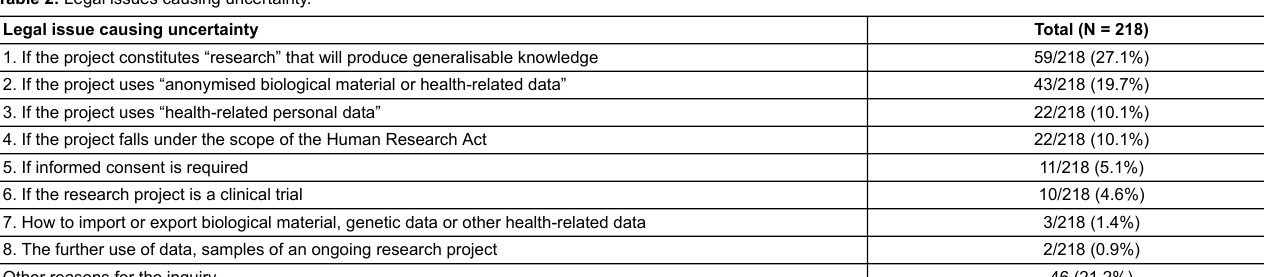
Table 2: Legal issues causing uncertainty.